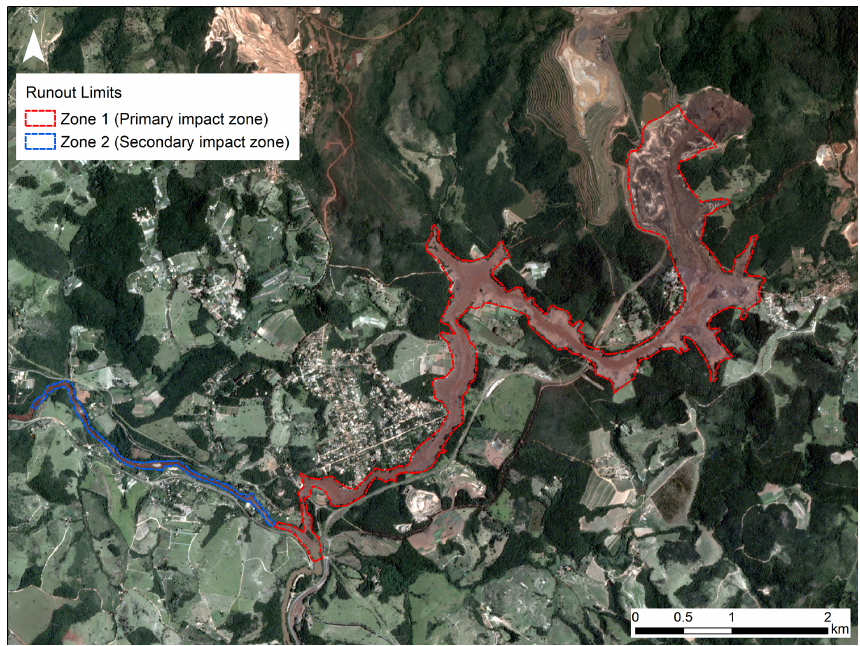
Figure 4. Aerial view of the tailings dam breach at the Feijão mine near Brumadinho, Brazil, 25 January 2019. Zone 1 is shown in the red dashed polygon. The portion of Zone 2 that is visible in this image is shown in the blue dashed polygon. Image courtesy of Planet Labs, Inc. (29 January 2019).